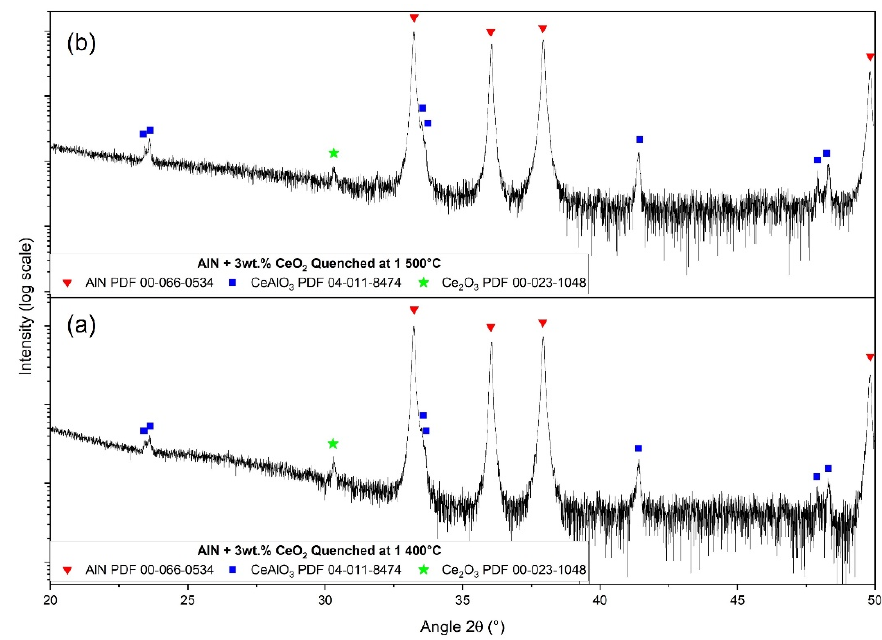
Figure 13. X-ray diffraction patterns of AlN + 3 wt.% CeO 2 samples quenched under nitrogen at ( a ) ( a ) 1400 ◦ C, ( b ) 1500 ◦ 1400 °C, ( b ) 1500 °C.